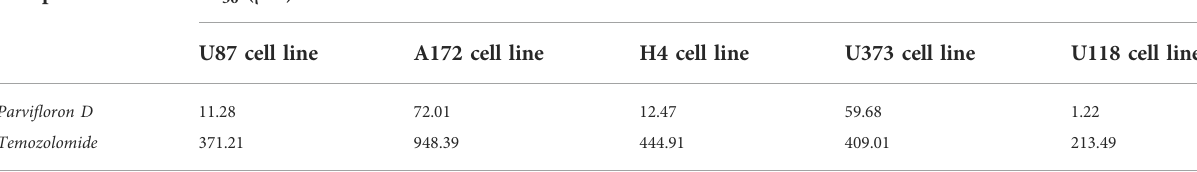
TABLE 2 Half-maximal inhibitory concentration (IC 50 ) values for parvi fl oron D and temozolomide in a panel of GB cell lines. Compound